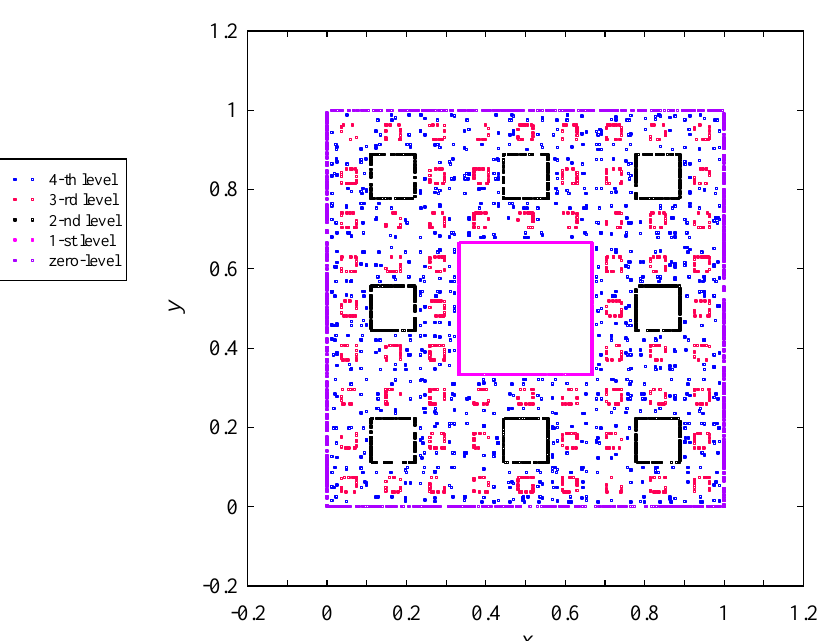
Figure 8. Level-controlled point clouds of the Sierpinski Carpet up to the fourth level generated from a relatively small seed point cloud.